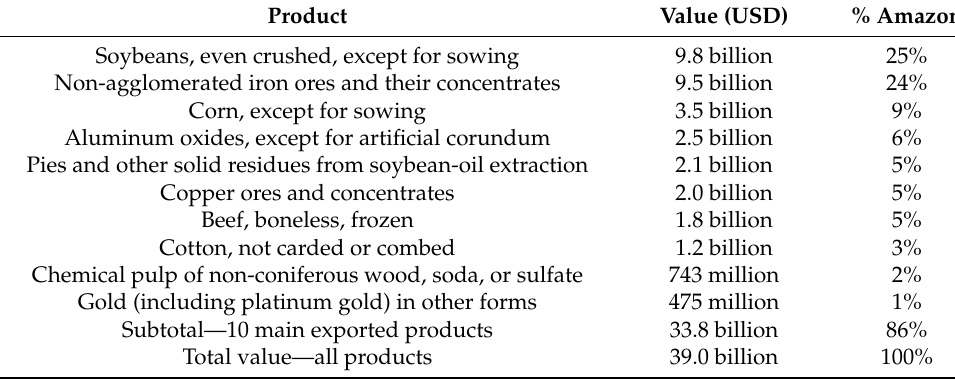
Table 9. Main Products Exported by the Brazilian Amazon 2017–2019. Source: [33]. Product Value (USD) % Amazon Soybeans, even crushed, except for sowing 9.8 billion 25% Non-agglomerated iron ores and their concentrates 9.5 billion 24% 3.5